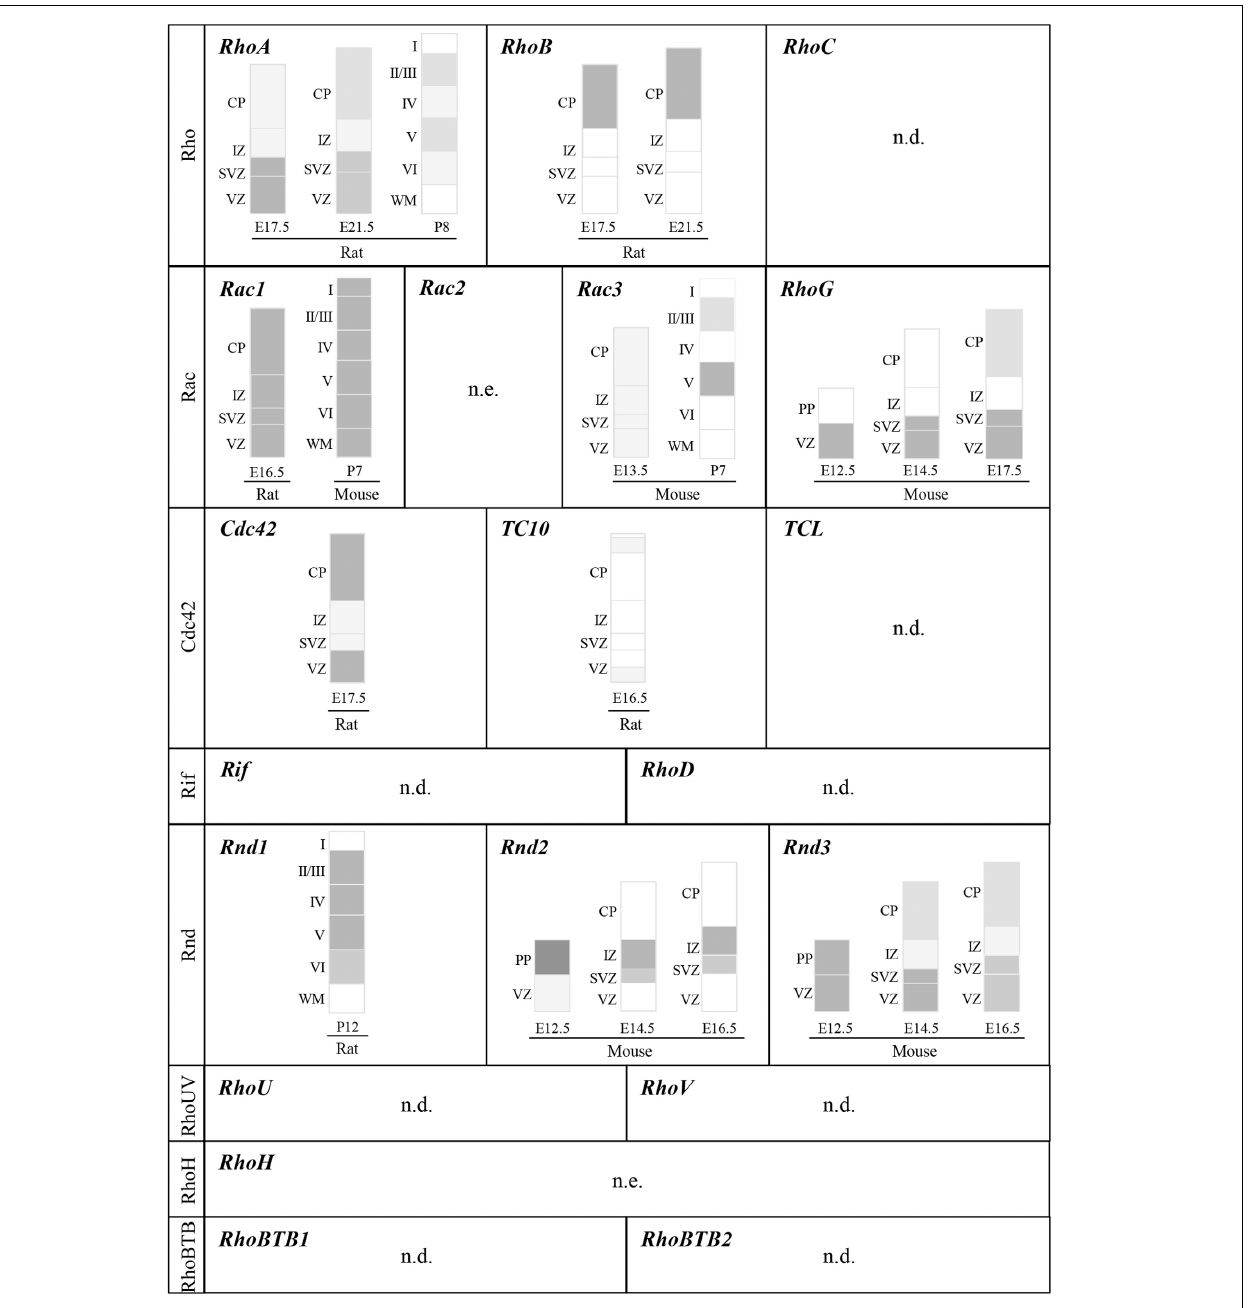
DEVELOPING CEREBRAL CORTEX should be consulted for details on expression patterns and changes in expression during development. Dark gray and light gray indicate higher and lower relative levels of expression, respectively. VZ: ventricular zone; SVZ: ventricular zone; IZ: